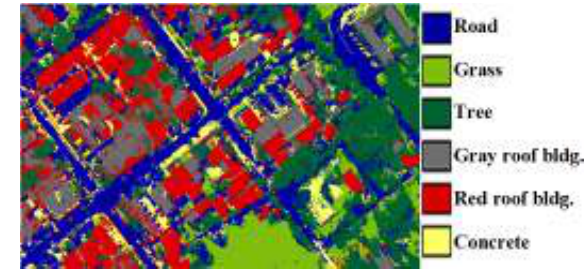
Figure 3. Results obtained for the RGB+DSMnThr combination.